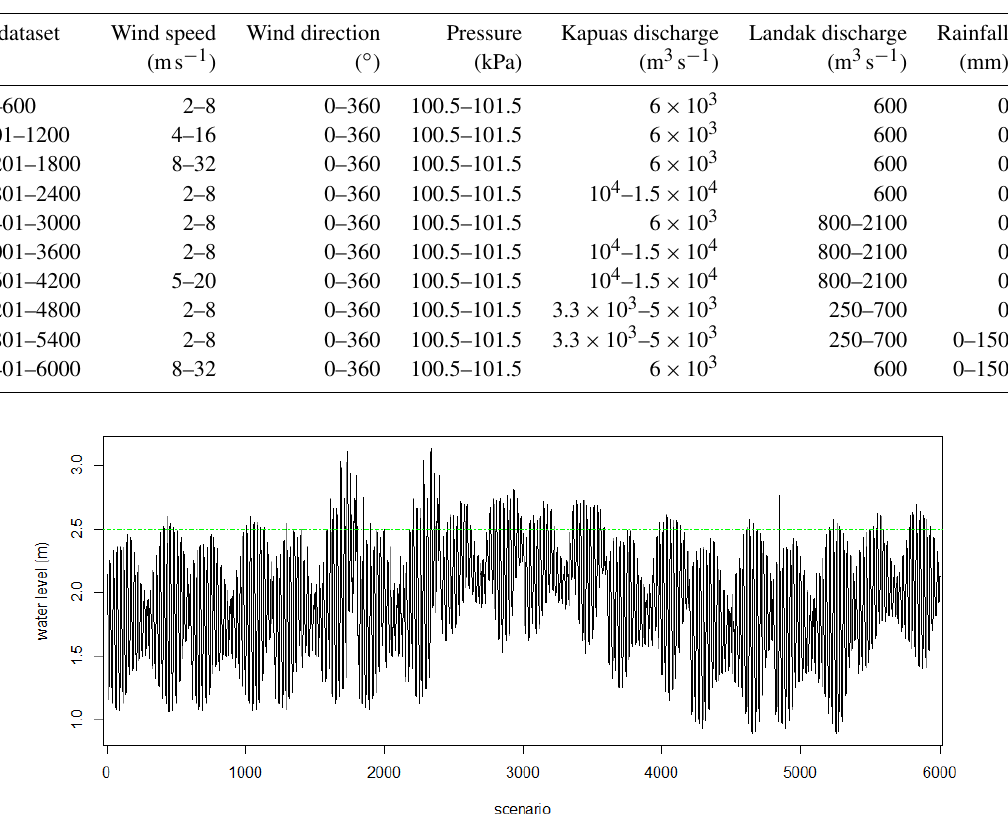
Figure 6. The Kapuas Kecil River’s water level in Pontianak, obtained from the hydrodynamic model. The green dashed line is the threshold above which the water starts to overflow the riverbanks in